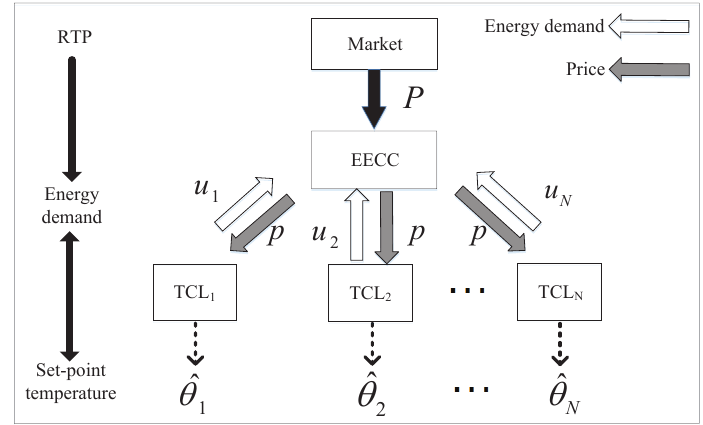
Figure 1. The framework of the energy trading